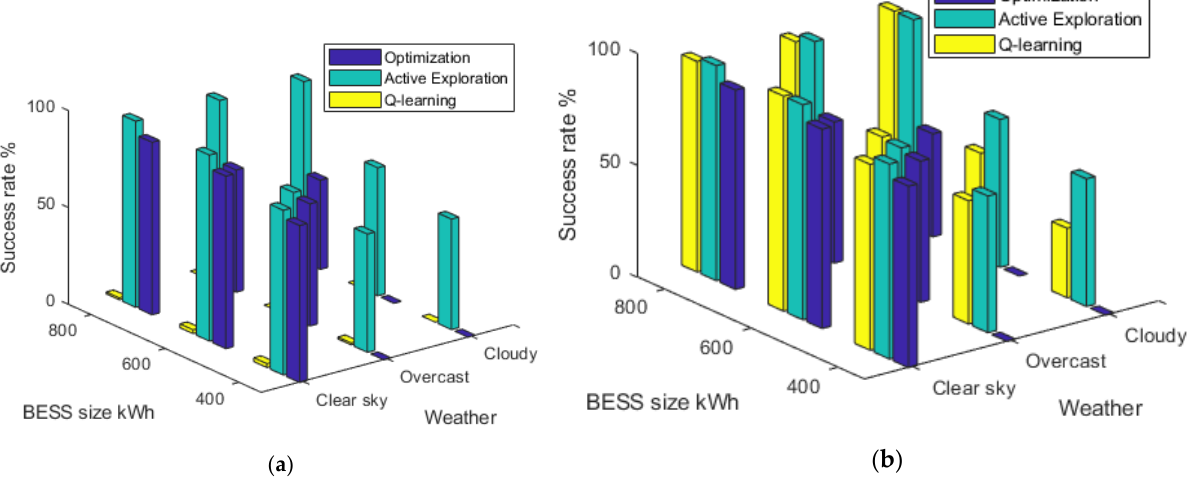
Figure 11. Success rate comparison under the different BESS size and weather conditions: ( a ) maximum episode is 3000; ( b ) maximum episode is 6000.